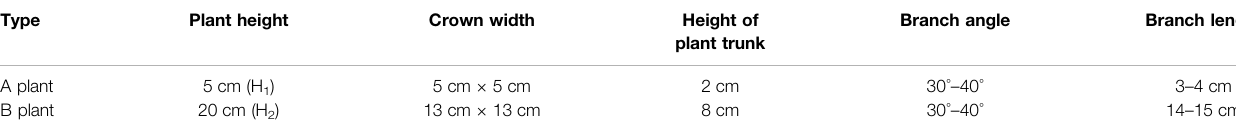
TABLE 3 | Selection table of plant parameters. Type